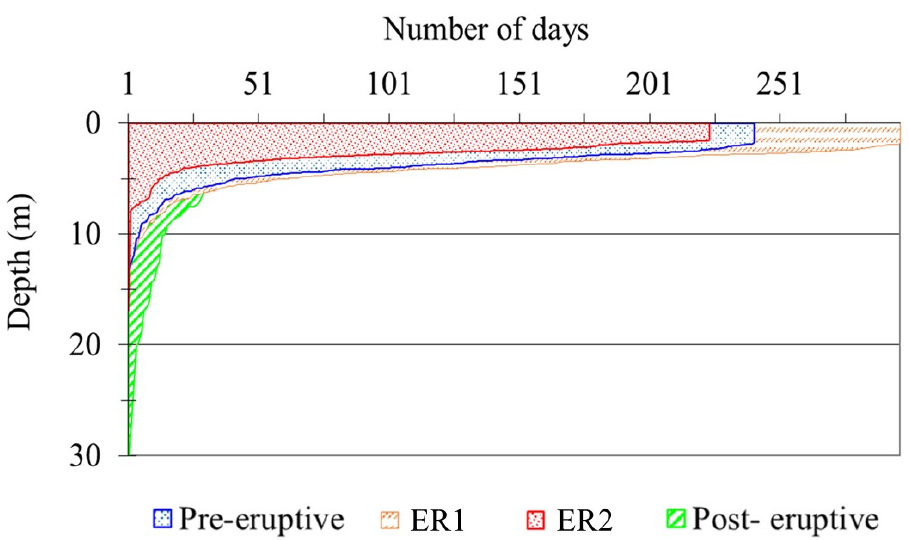
Figure 3. Depths of Z1 front extrapolated at the BTL monitoring station and grouped according to the different volcanic phases: pre-eruptive, eruptive (ER1 ER2 periods), and post-eruptive.